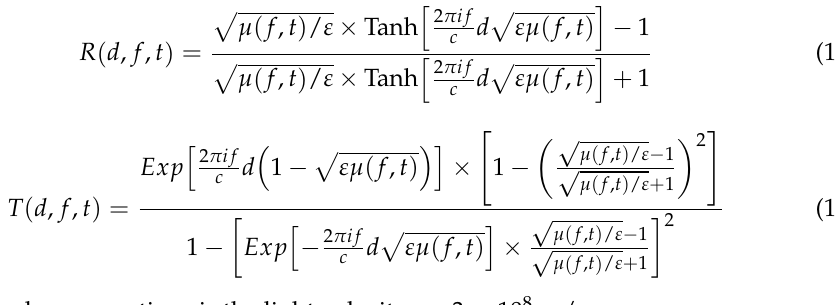
(cid:104) (cid:104)(cid:112) (cid:105)(cid:105) 2 π if d × Im εµ ( f , t ) c (cid:2) (cid:112) (cid:3) µ / ε decreases